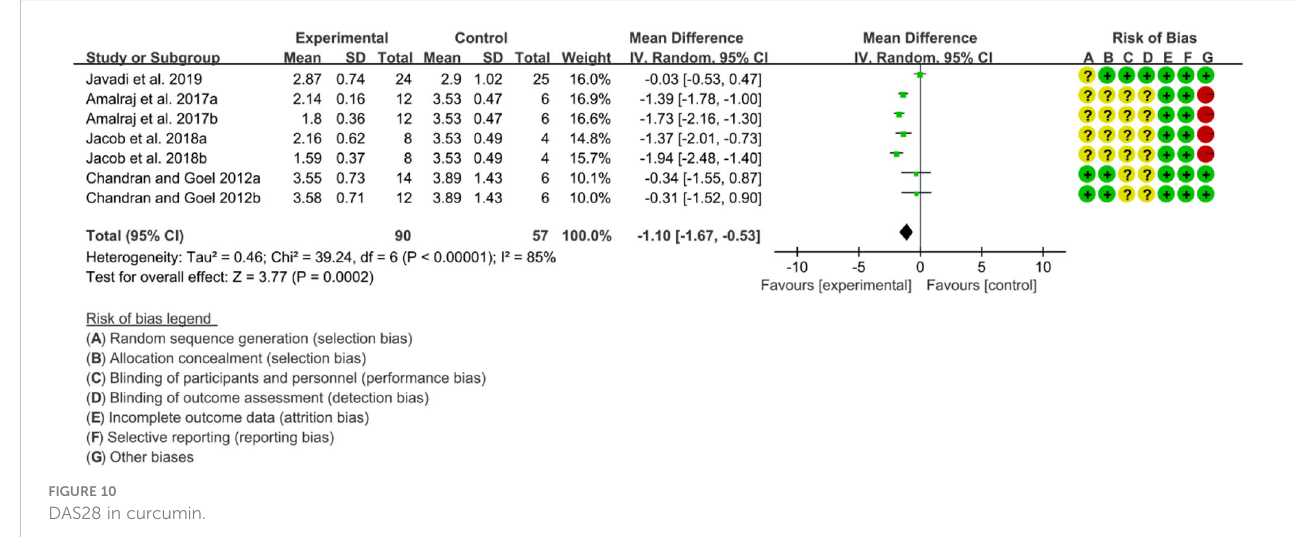
FIGURE 10 DAS28 in